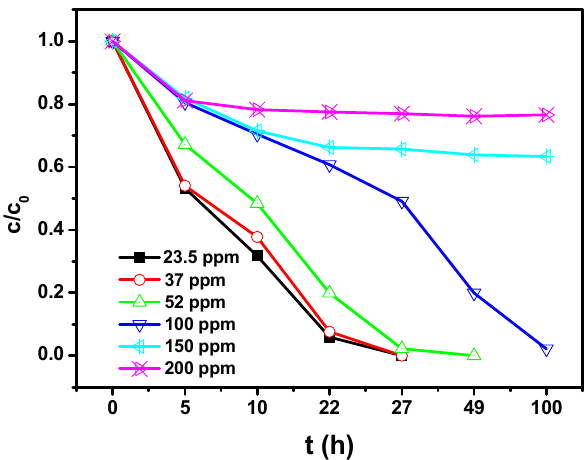
Figure 8. Effect of CTAB concentration on the sorption of positively charged AuNPs.